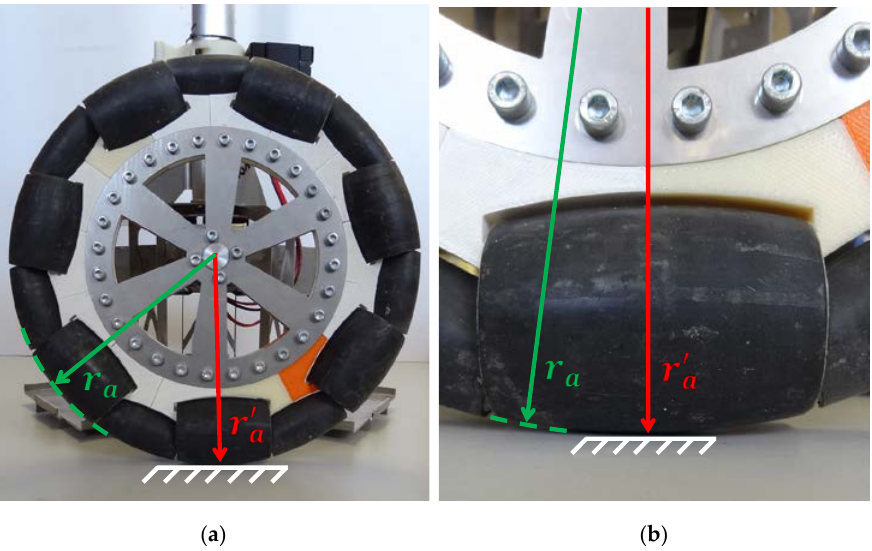
Figure 3. General view ( a ) and detail ( b ) of the wheel radius and the point of contact of the wheel with the floor: r a depicts the nominal radius (green font and lines) and r (cid:48) a the real or effective radius (red font and lines).